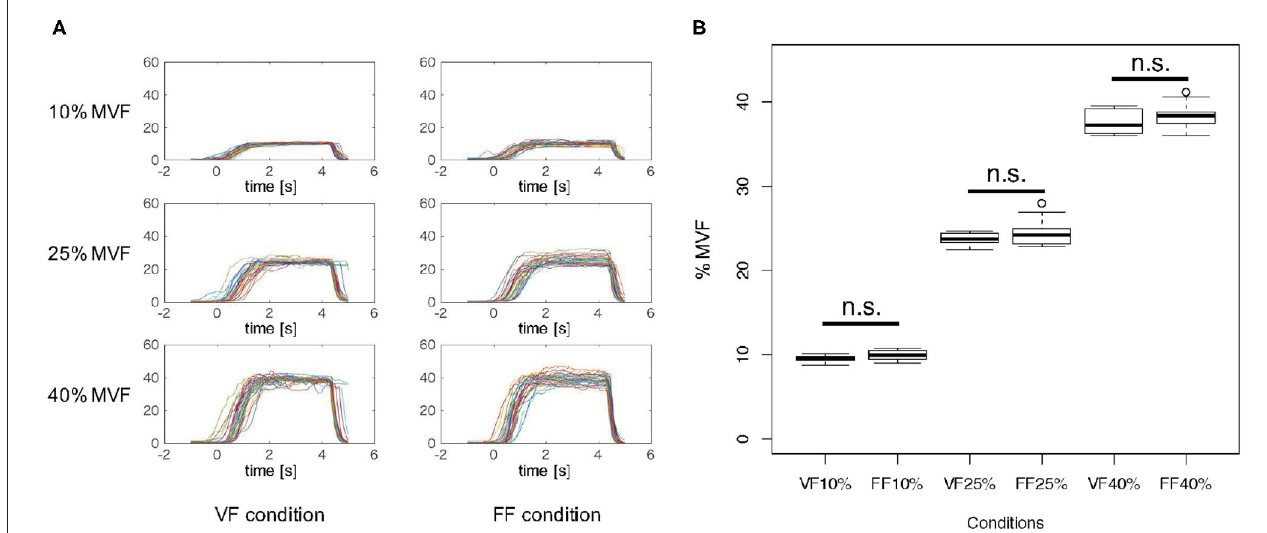
FIGURE 3 | Grasping force in %MVF measure. (A) Grasping force time-series of a typical participant (Participant B) in %MVF measured under each experimental condition. Each graph includes 30 trials. As shown in these graphs, the grasping forces were maintained during 1.0–4.0s, and a relatively large variability was observed in the FF condition. (B) Mean and standard error of grasping forces during 1.0–4.0 s across participants in each condition. Two-way ANOVA revealed a significant main effect of %MVF levels, but no significant difference was observed between feedback conditions. This implies that the participants exerted identical motor outputs in both VF and FF